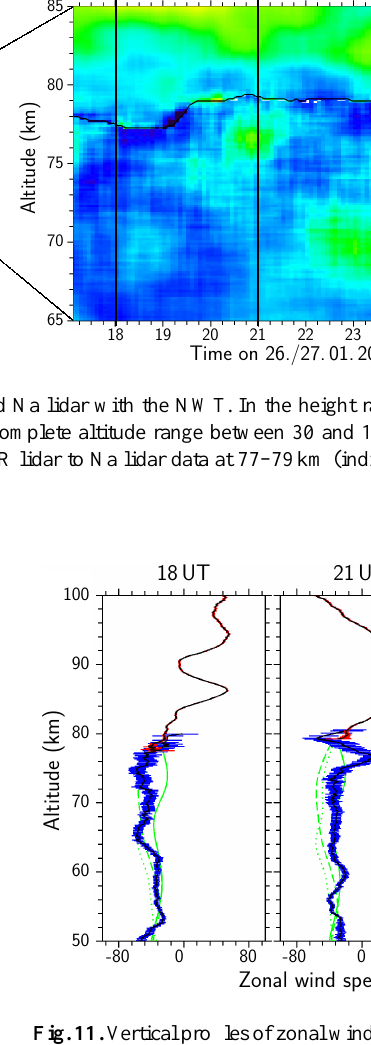
Fig. 11. Vertical profiles of zonal wind speed on 26/27 January mea- sured by RMR lidar (blue error bars) and Na lidar (red error bars) with the NWT. Green lines show wind speed profiles from ECMWF data (solid: closest, dashed: 6h earlier, dotted: 6h later). Integra- tion time for lidar data is 1h. Profiles are centered at 18:00UT, 21:00UT, and